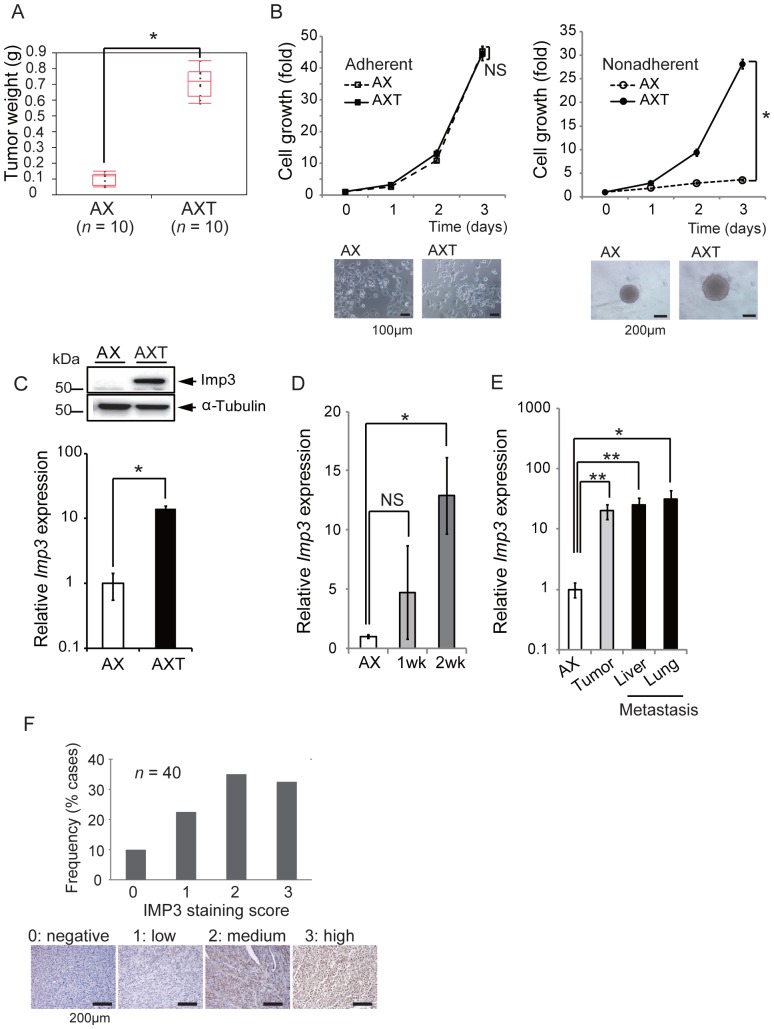
Up-regulation of Imp3 expression during tumor formation in vivo.(A) AX or AXT cells were injected bilaterally and subcutaneously into syngeneic mice, and the weight of the tumors was measured. *P<0.0001. (B) Cell proliferation assays for AX or AXT cells cultured under adherent or nonadherent conditions. *P<0.001. NS, not significant. Representative bright-field images of cells after culture for 2 days are shown. (C) Immunoblot analysis of Imp3 expression in AX and AXT cells. α-Tubulin was examined as a loading control. Real-time PCR analysis of Imp3 expression in AX and AXT cells. *P<0.01. (D, E) Real-time PCR analysis of Imp3 expression in subcutaneous AX cells at 1 or 2 weeks after injection into mice, and in primary tumors and metastatic lesions formed by AX cells. *P<0.05, **P<0.01. NS, not significant. (F) Immunohistochemical staining of IMP3 in human osteosarcoma samples. The intensity of staining was scored from 0 to 3. Representative images are shown.